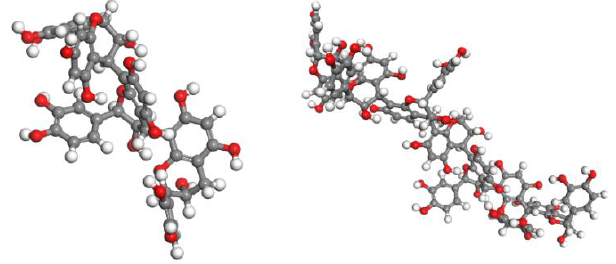
Figure 4. Optimized structures of proanthocyanidins (left, trimer; right, heptamer).